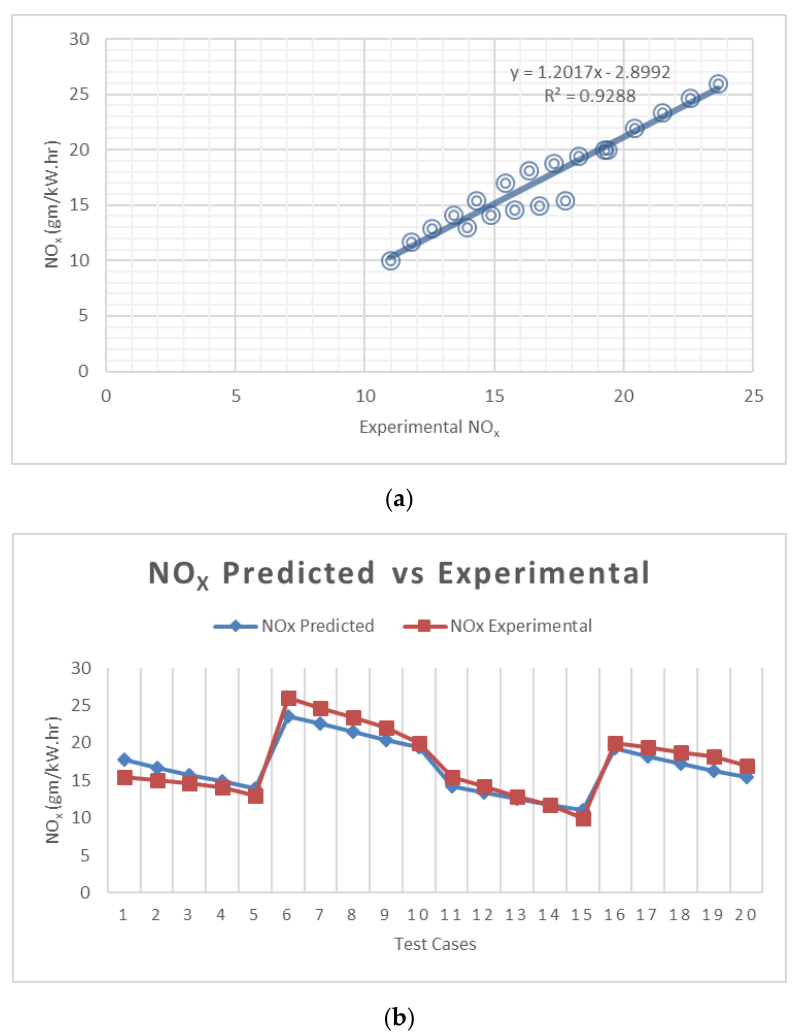
Figure 10. ( a ) Depiction of predicted and experimentally obtained NO x values taken for 20 test cases; ( b ) Regression coefficient for the values predicted using ANN Vs experimental.